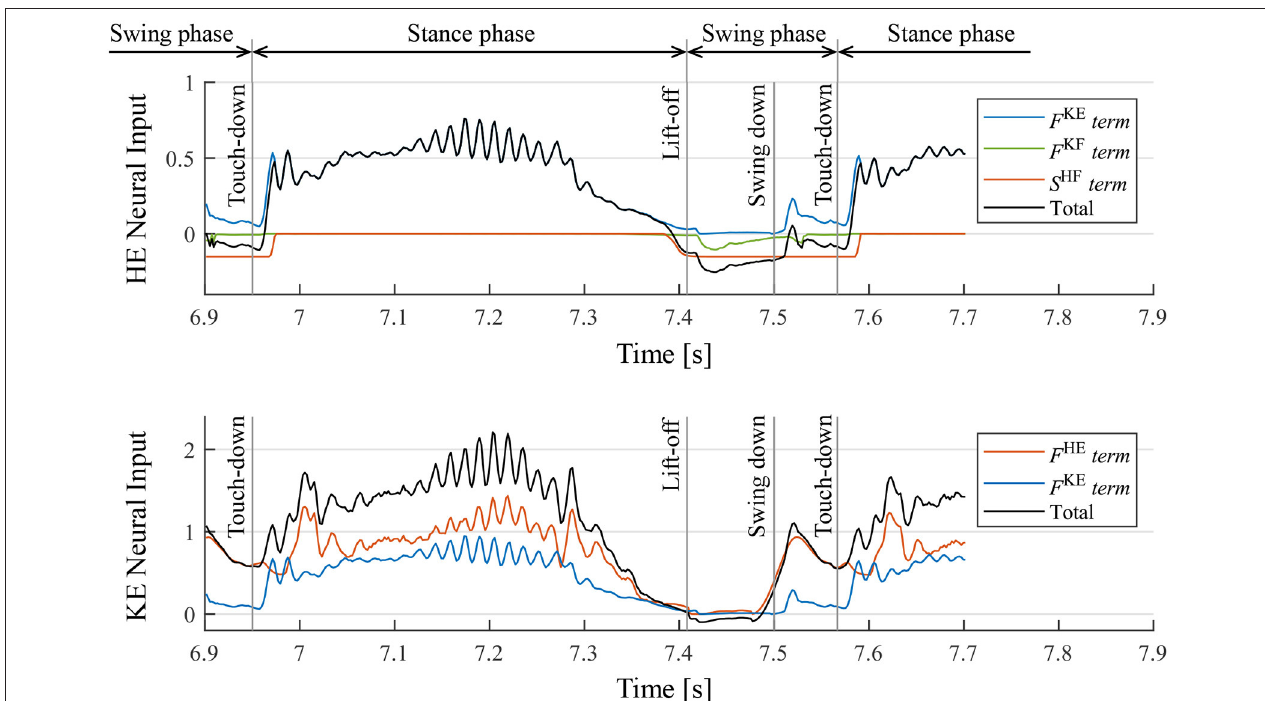
FIGURE 10 | Neural input to interneurons of the hip extensor (HE) and knee–ankle extensor (KE) and the breakdowns. F KE , F KF , and F HE are the magnitude of the muscle force feedback, and S HF is the inhibitory neural input from the interneuron of the antagonist muscle. It should be noted that the sum of the knee–ankle extensor neural inputs includes an offset of –0.1.